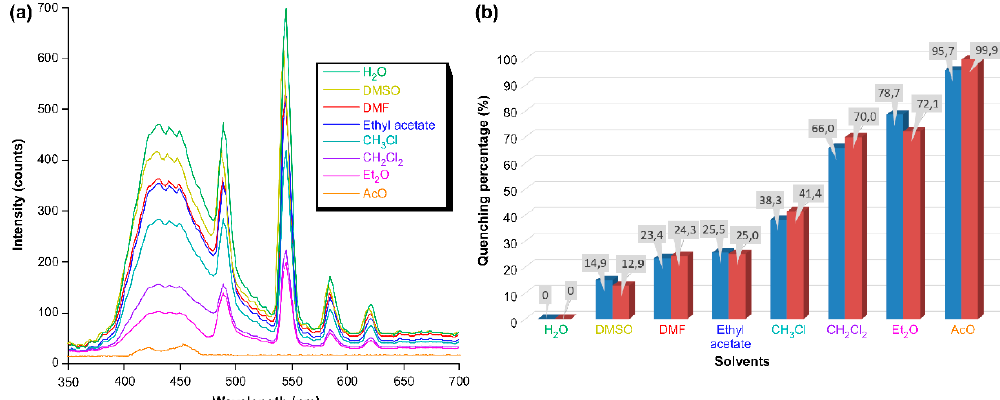
Figure 9. ( a ) Intensity-dependent emission of compound 2 dispersed under different solvents. ( b ) Bar chart plot showing the quenching percentage of the LC ( λ em = 450 nm, blue bars) and Tb-based 5 D 4 → 7 F 5 transition ( λ em = 548 nm, red bars).